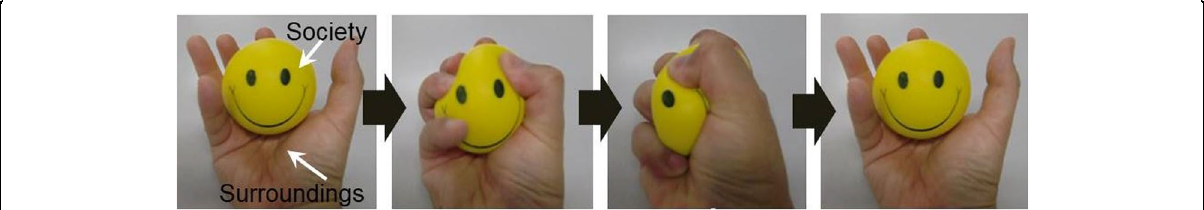
Fig. 3 Resilient Society: quick and fully recovery from natural